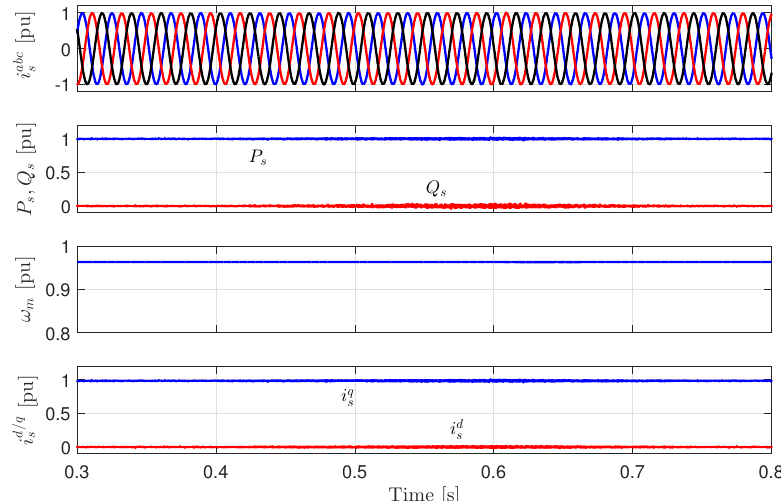
Figure 3. Performance of the MSC and PMSG during a three-phase fault without FRT strategy (from top ): PMSG output currents i abc s = ( i a s , i b s , i c s ) (cid:62) , PMSG active and reactive power ( P s , Q s ), mechanical speed of the PMSG rotor ω m , and d - and q -axis currents of PMSG ( i d s , i q s